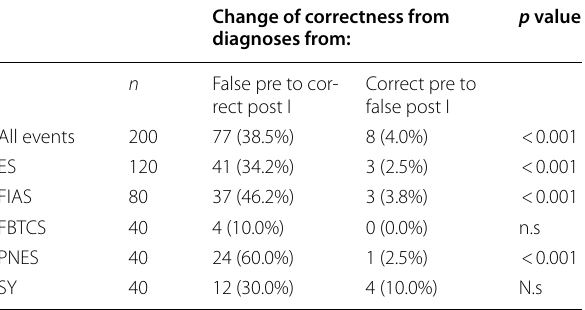
Table 2 Summary of training effect analysis before (pre) and immediately after the lesson (post